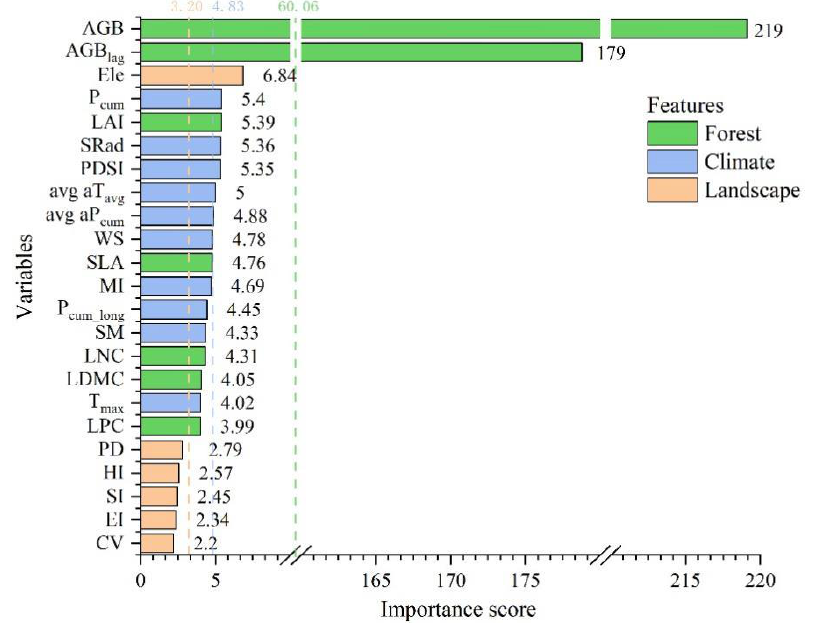
Figure 8. Variable importance scores for the optimal vulnerability model. Green, blue and orange dotted lines represent the mean importance scores of categories for forest features, climate features and landscape features, respectively.